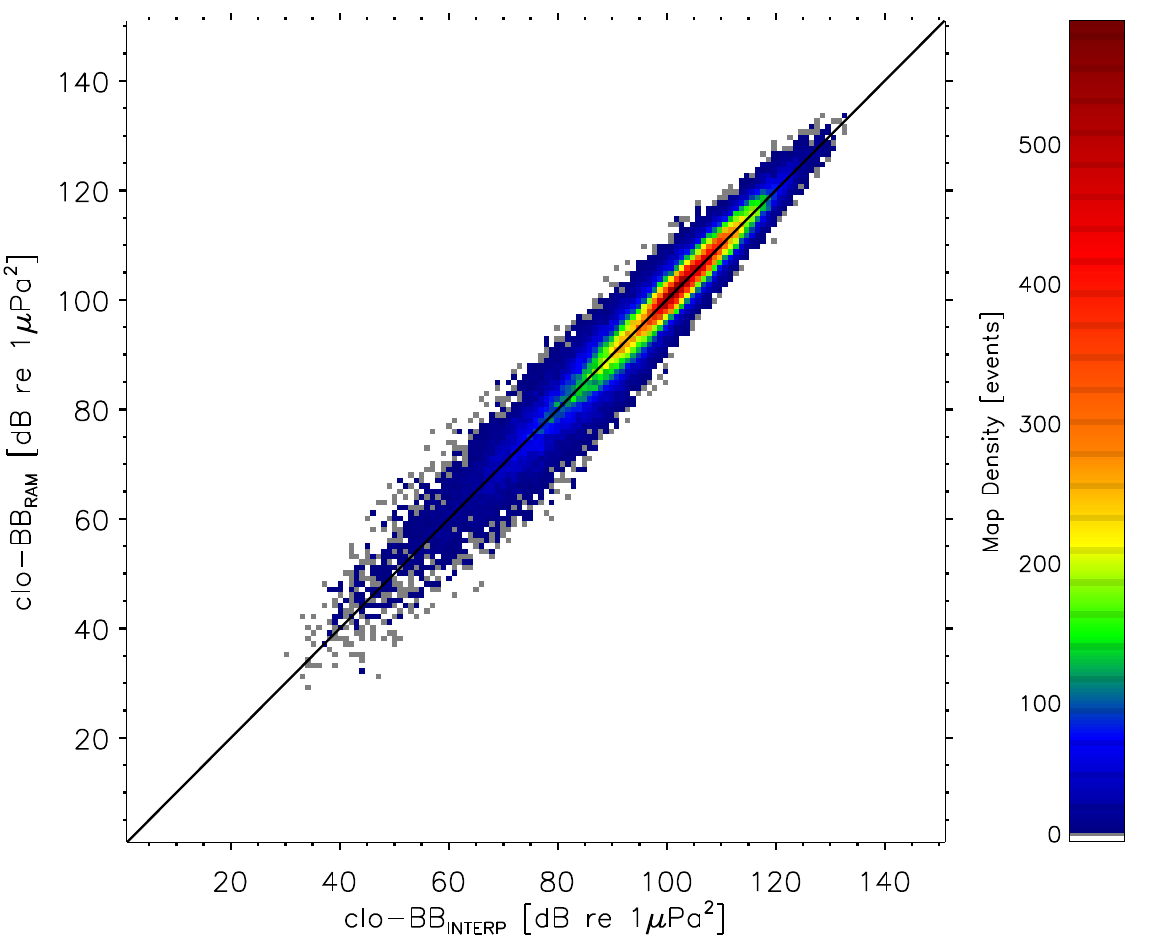
Figure 4. Density plot of the point-to-point comparison of the clo-BB INTERP vs. clo-BB RAM predictions following the application of the GBM model on the lower half of the GT simulation and timestep numbers not divisible by 10 between 5041 and 10,080 (see text). A total of 102,868 ship-to-animal pairs are displayed. A binsize of 1 dB was used to process the square map with colored density levels between 0 and 588